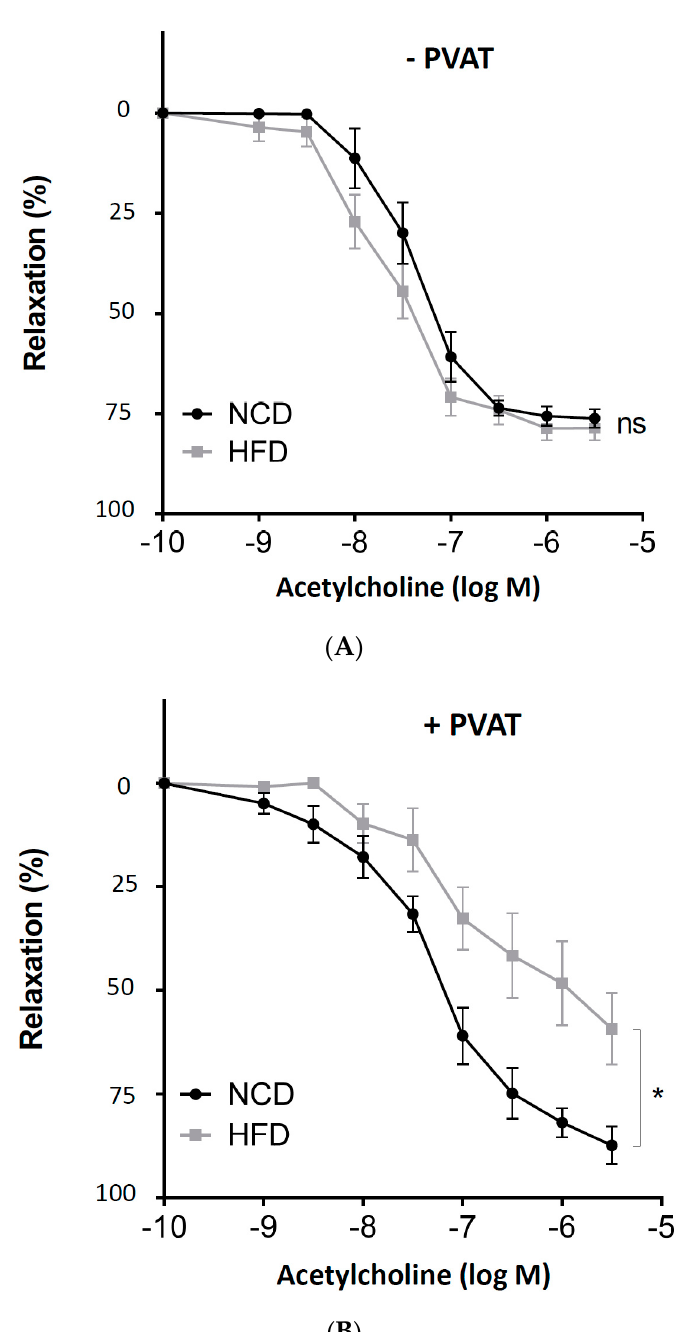
Figure 1. The role of perivascular adipose tissue (PVAT) in obesity-induced vascular dysfunction. Male C57BL/6J mice were treated with normal control diet (NCD) or high-fat diet (HFD) for 20 weeks. Aortic rings without ( A ) or with PVAT ( B ) were used for vascular function assessment with a wire myograph system. The rings were precontracted with noradrenaline, followed by relaxation in response to increasing concentrations of acetylcholine. Symbols represent mean ± SEM. ns, not significant; * p < 0.05; n = 8.